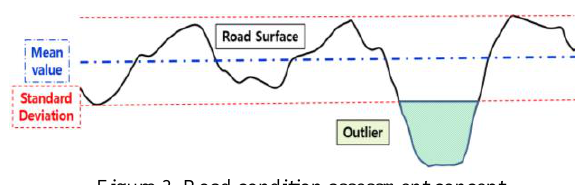
Figure 3. Road condition assessment